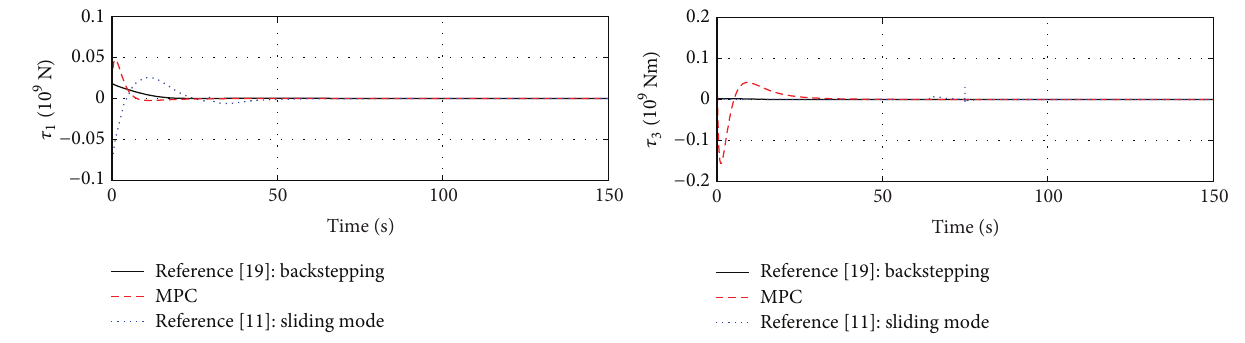
Figure 5: Control